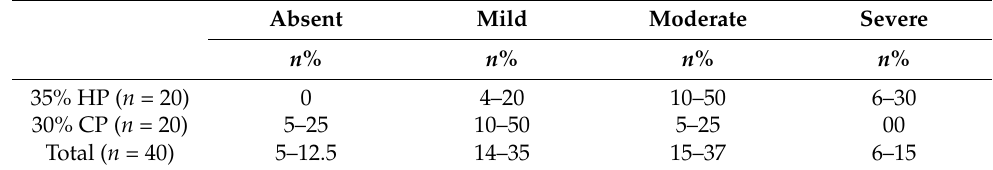
Table 3. Tooth sensitivity after bleaching treatment (Sceffe’s